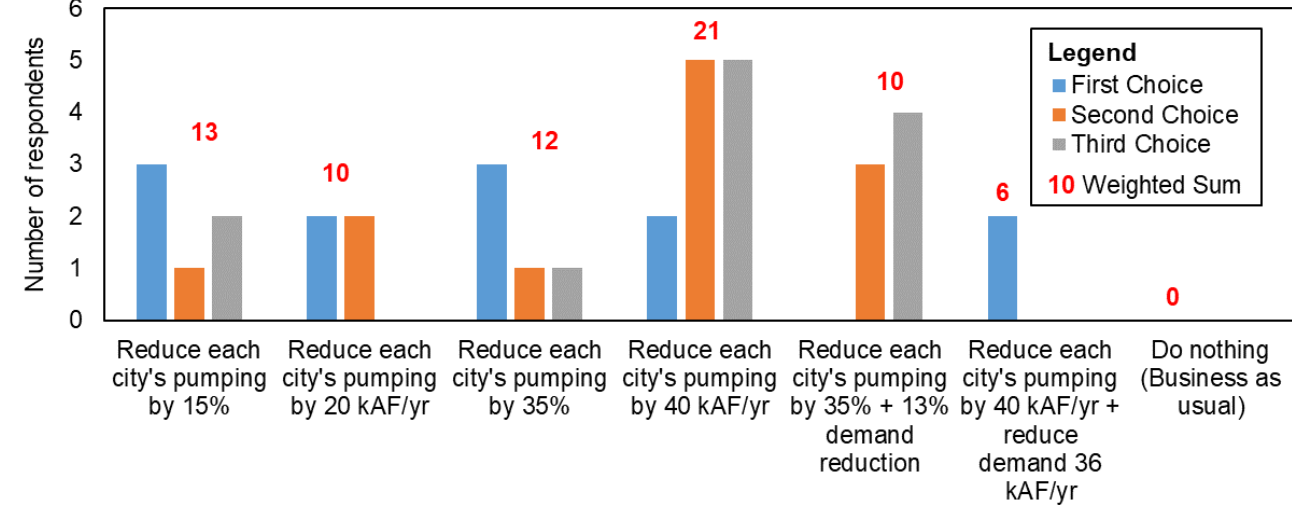
Figure 3. Results of polling on options for reducing depletion times (numerical values in red bold are weighted sums of choices).